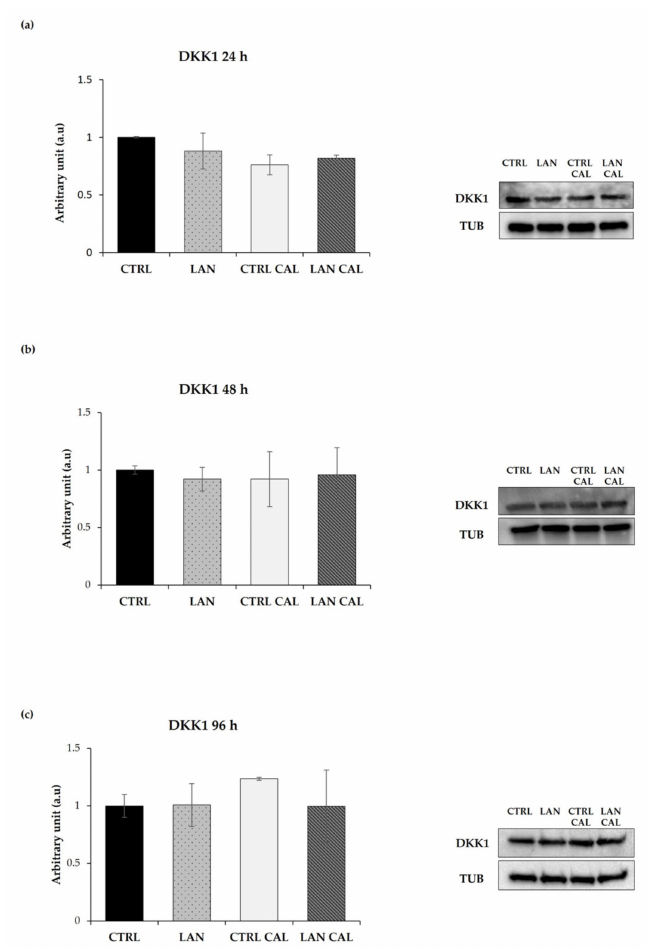
Figure 5. The Western Blotting analysis of DKK1 in EA.hy926 treated with lanthionine alone and with pro-calcifying Ca 2+/ P medium. The molecular characterization of intracellular DKK1 levels expressed in endothelial cells after 1 µ M of lanthionine and 1 µ M of lanthionine with 2.8 mM of CaCl 2 and 3 mM of NaH 2 PO 4 treatment at 24 h, 48 h and 96 h. ( a – c ) The Western Blot analysis of DKK1 protein abundance in endothelial cells; Tubulin is the loading control; the relative differences in protein levels shown (right of the panel) were quantitated by using Image Lab Software, normalized to Tubulin levels and expressed as arbitrary units (a.u). The untreated control is shown as a bar equal to 1. The columns represent the mean and error bars indicating the SD from three independent experiments, (according to Anova test). CTRL, untreated control; LAN, lanthionine; CTRL CAL, with 2.8 mM of CaCl 2 and 3 mM of NaH 2 PO 4 ; LAN CAL, lanthionine with 2.8 mM of CaCl 2 and 3 mM of NaH 2 PO 4